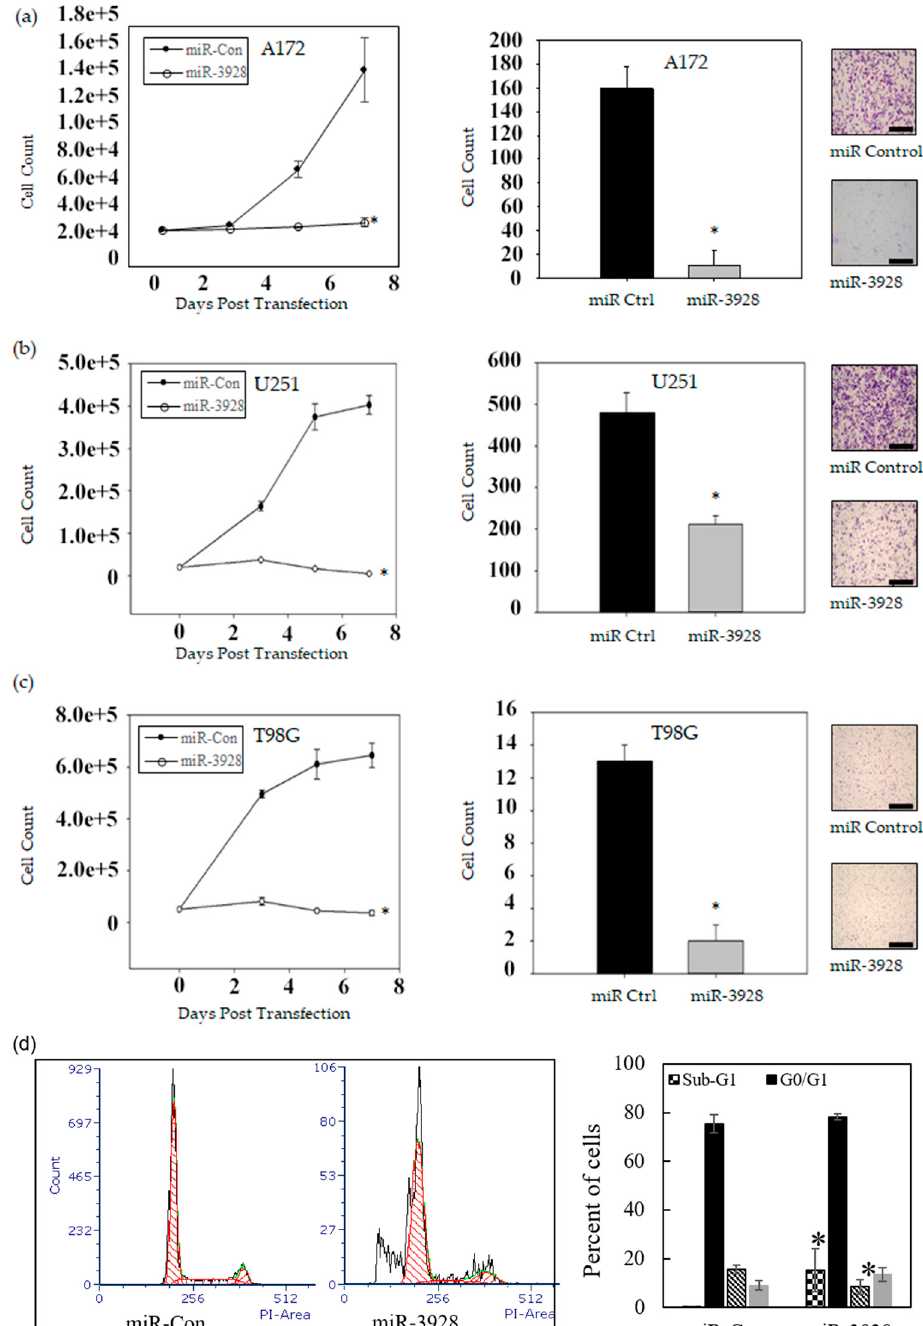
Figure 3. miR-3928 inhibits GBM cell proliferation and invasion. ( a ) A172 cells transfected with either miRNA scrambled control or miR-3928 were trypsinized and counted at 3, 5, and 7 days post transfection. Overexpression of miR-3928 inhibits cell growth of A172 cells (left panel); A172 cells transfected with miRNA scrambled control or miR-3928 were also cultured on collagen IV coated Boyden Chambers at 3 days post transfection. Invasive cells were imaged and analyzed. Representative images are shown (right panel). The quantified data show that miR-3928 inhibits cell invasion across the collagen matrix (middle panel). ( b , c ) Cell growth and invasion assay in U251 ( b ) and T98G cells ( c ) show that miR-3928 overexpression leads to the inhibition of both cell growth and invasion as compared to scrambled control. All growth assays were performed in triplicates. Scale bars are 1 mm; ( d ) Propidium iodide flow-cytometric cell-cycle analysis shows that miR-3928 increases the sub-G1 population and leads cell cycle arrest at G1/S in A172 cells. * = p ≤